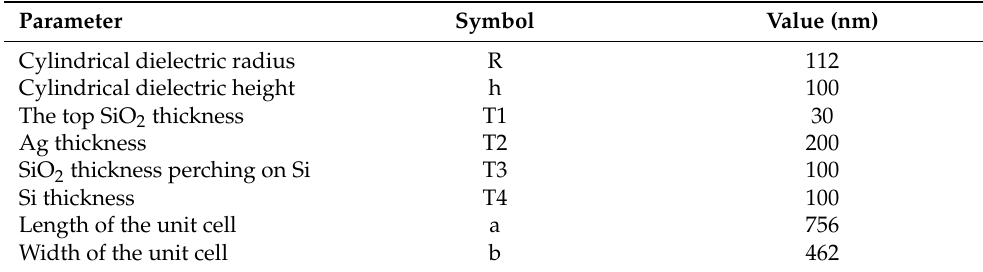
Table 1. Geometrical characteristics of a unit cell of the proposed structure.